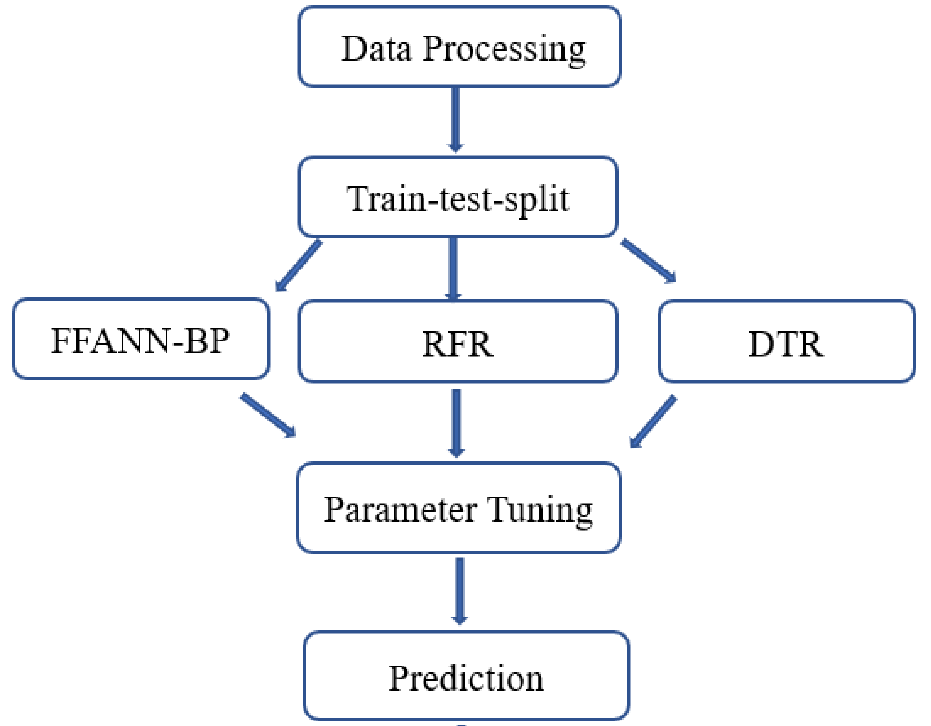
Figure 6. The flowchart of our